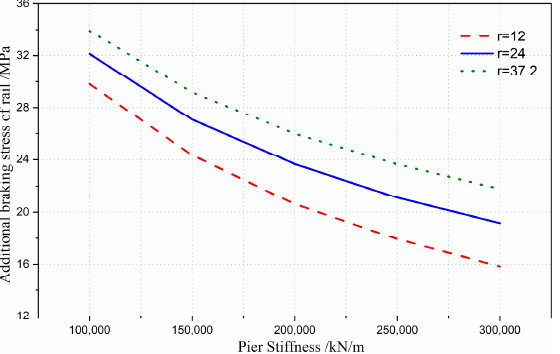
Figure 20. Additional braking stress of the rail under different pier stiffness.